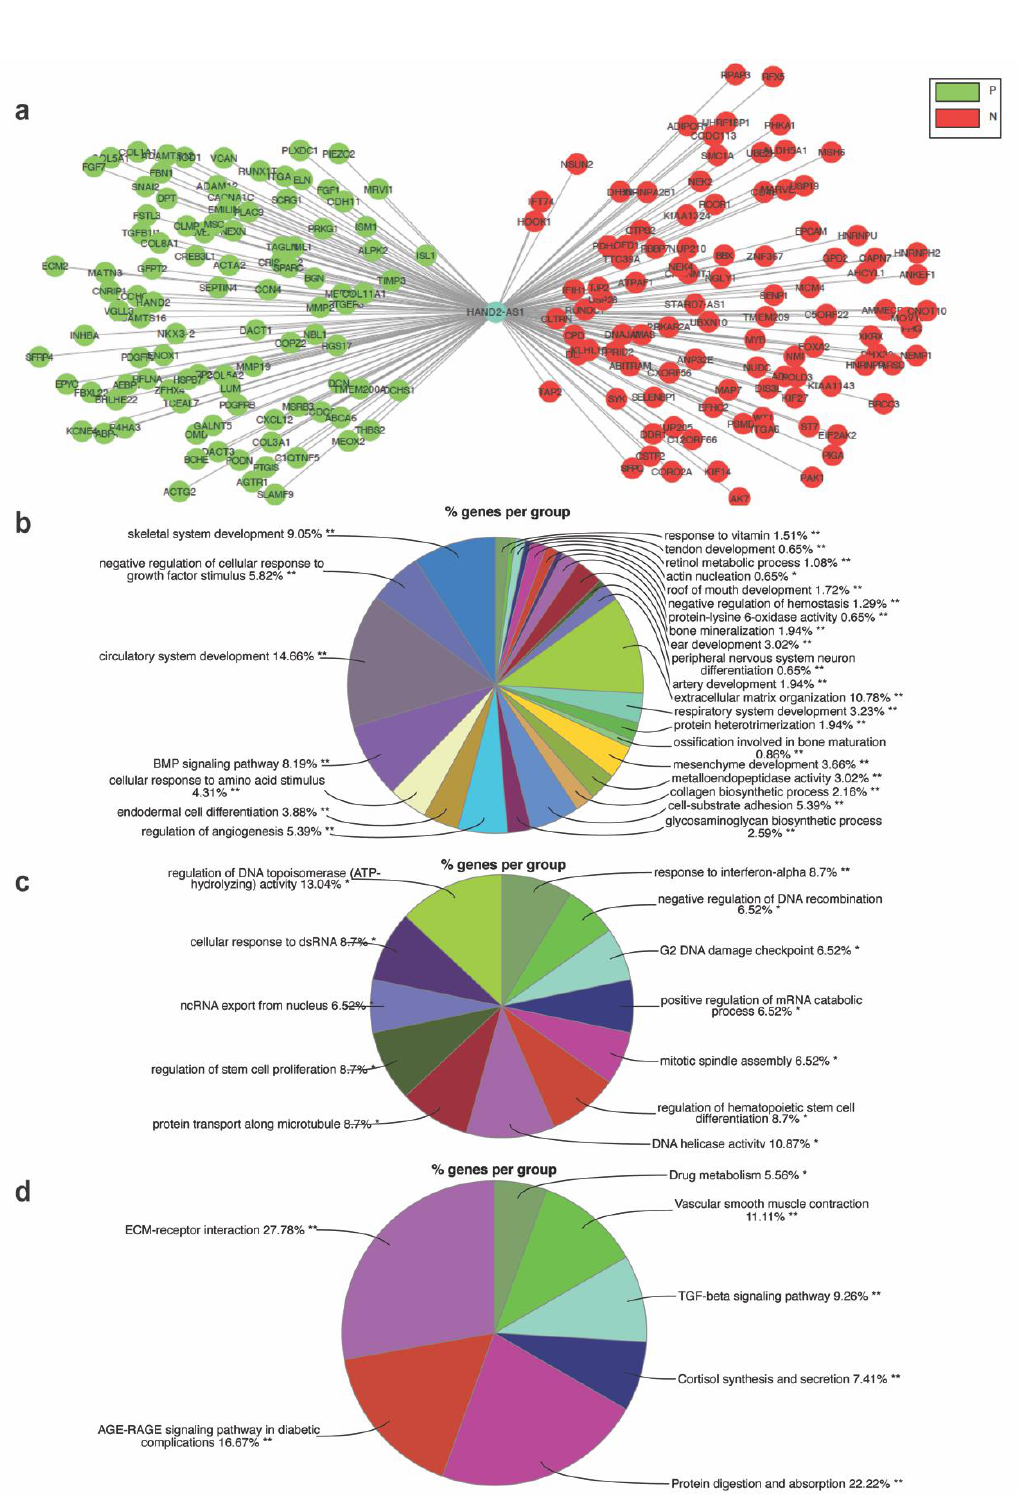
Figure 5. ( a ) Proposed mRNA network constructed bioinformatically for HAND2-AS1 with putative target mRNAs positively and negatively correlated with HAND2-AS1 (cBioportal) in HGSC; All Gene Ontology (GO) biological process terms enriched by ( b ) positively correlated mRNAs and ( c ) negatively correlated mRNAs with HAND2-AS1; ( d ) all Kyoto Encyclopedia of Genes and Genomes (KEGG) pathways enriched by positively correlated mRNA with HAND2-AS1 in HGSC obtained using Cytoscape.